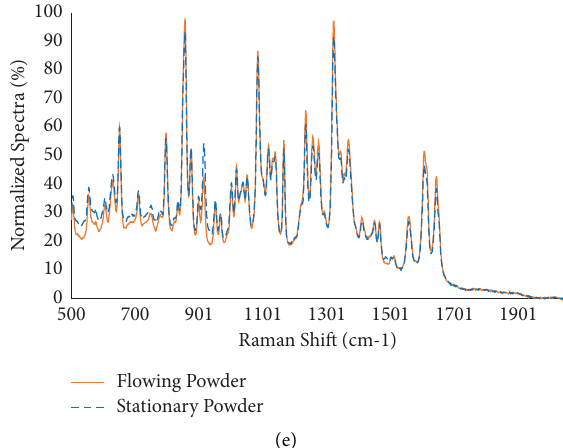
Figure 6: (a) Surface plot after SNV correction and (b) Raman spectra of stationary powder versus fowing powder at the feed frame; (c–e) Raman spectra of stationary and fowing powder inside the feed frame of tablet press with (c) 8% APAP in lactose, (d) 10% APAP in lactose, and (e) 12% APAP in lactose. Solid lines are Raman spectra of fowing powder and dotted lines are Raman spectra of stationary powder inside the feed